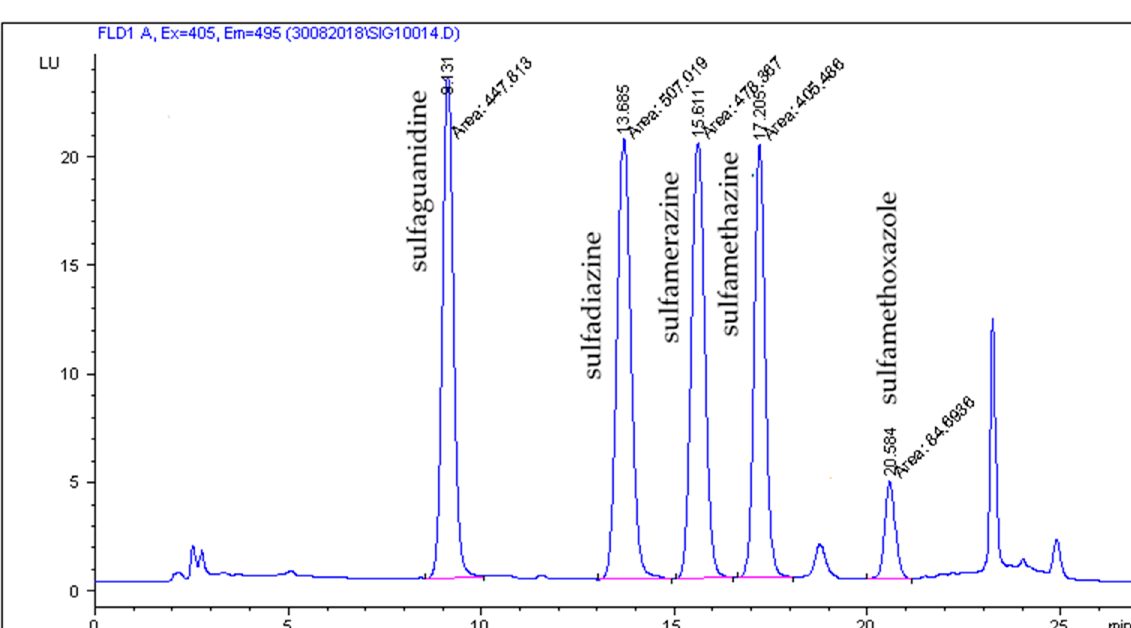
Figure 4. Liquid manure sample spiked five sulfonamides at the concentration level 50 µg/kg.